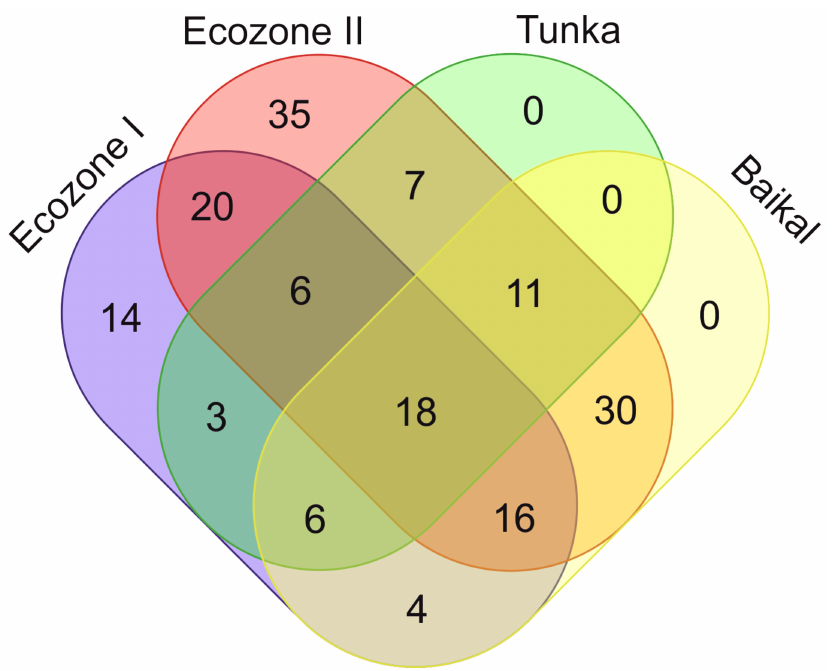
Figure 8. Venn diagram illustrating the number of common species between diatoms from Т unka-13 (Ecozone I, Ecozone II), Pliocene sediments in Tunka (by data from [6]), and modern phytobenthos from Lake Baikal